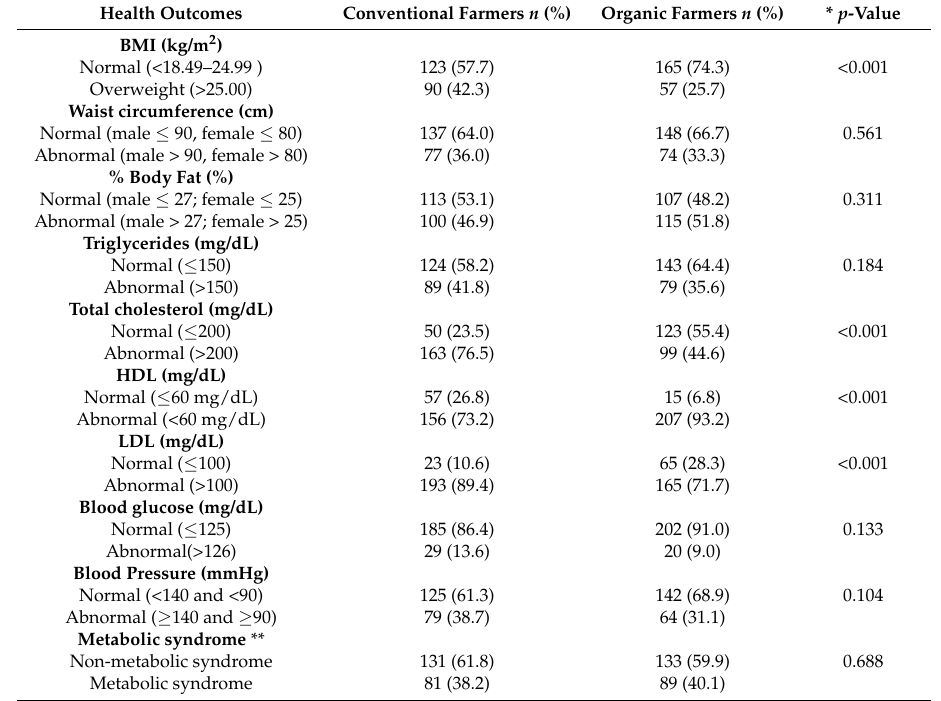
Table 5. Comparison of conventional ( n = 214) and organic farmers ( n = 222) for health outcomes using clinical criteria.